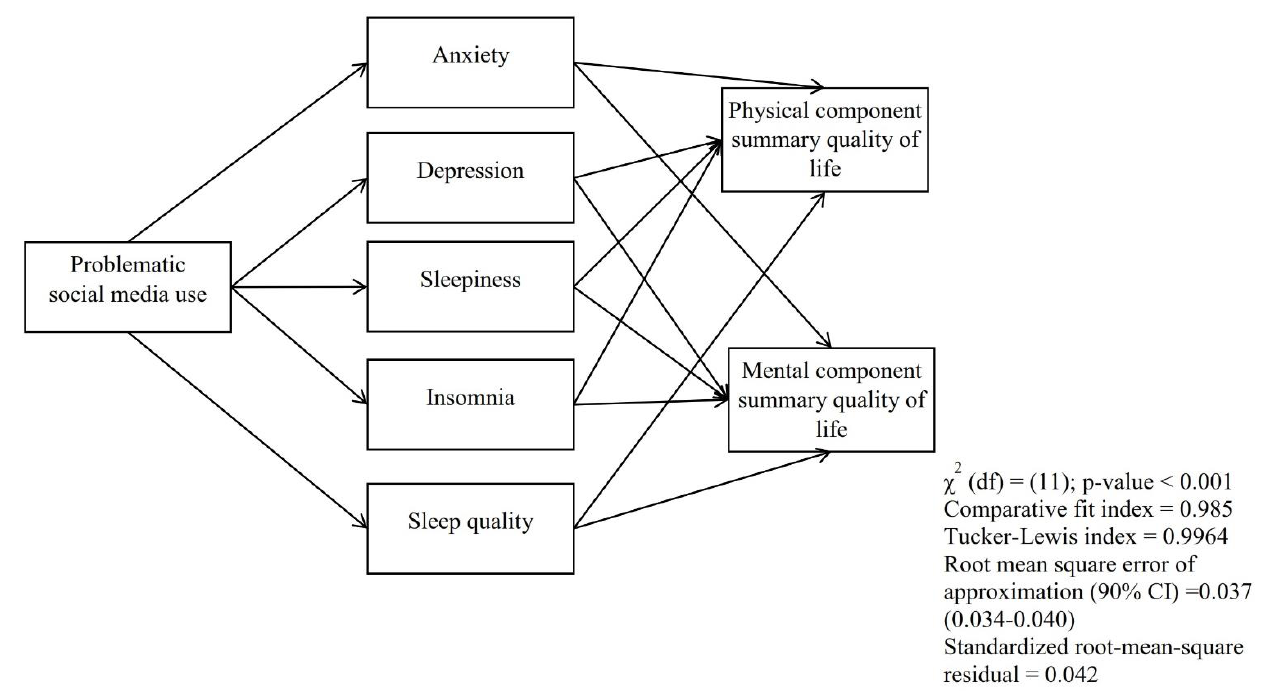
Figure 1. The mediation model via structural equation modeling (SEM) showing the mediating roles of anxiety, depression, sleepiness, insomnia, and sleep quality in the association between problematic social media use and quality of life among patients with cancer.